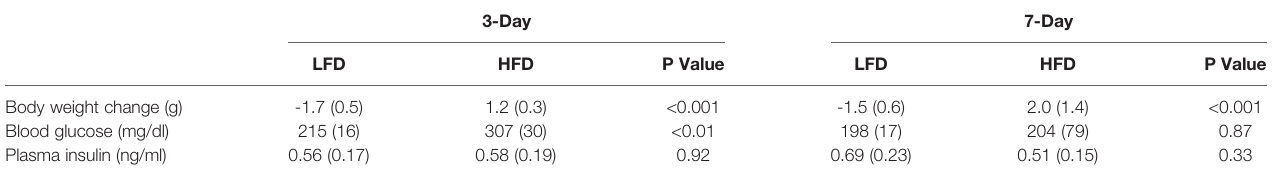
( Figure 2B ; interaction effect, p=0.06). Representative blot images are presented in Figure 2C .